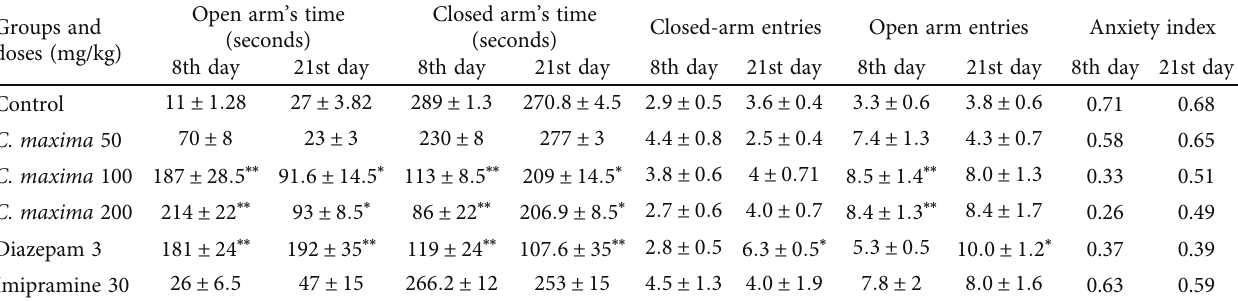
Table 7: E ff ect of C. maxima seed extracts on anxiety (elevated plus maze).